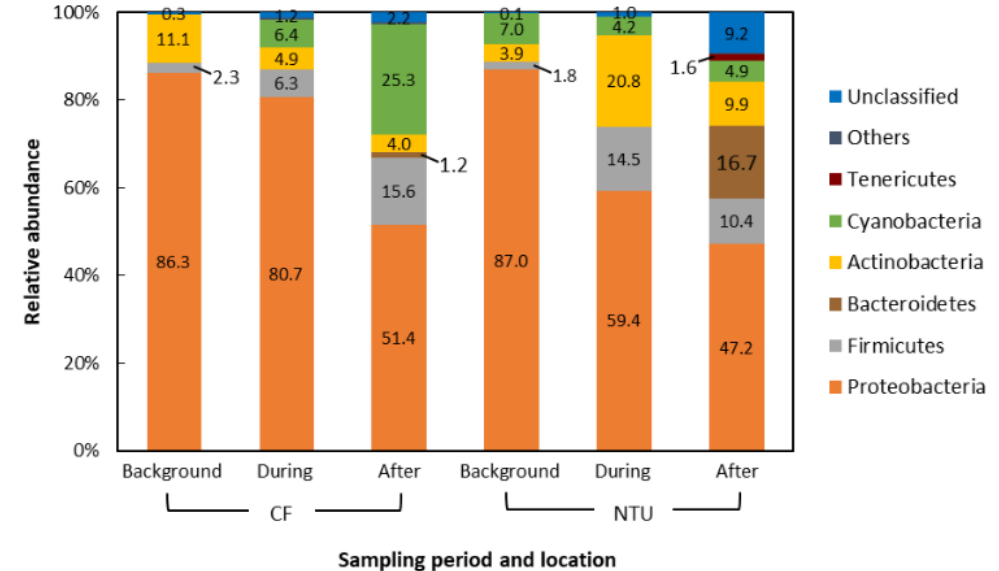
Figure 2. Compositions of the bacterial community at phylum taxon for FP1 (frontal pollution case 1). The phyla with the relative abundance of less than 1% were not